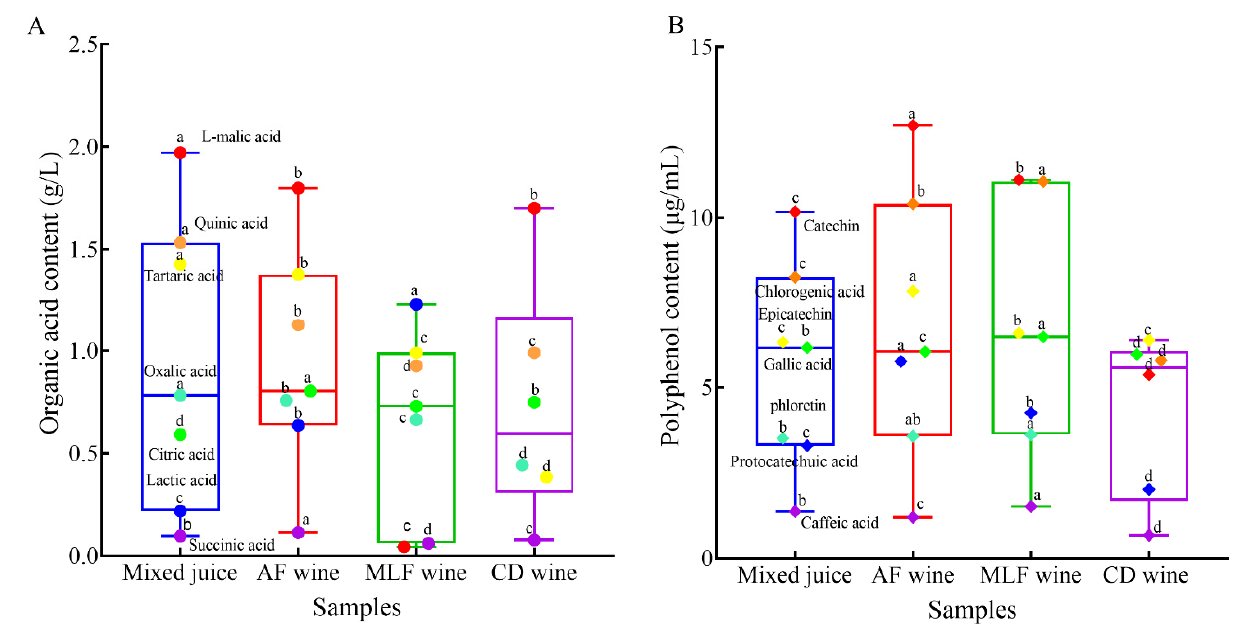
Figure 3. Deacidification modulates organic acid and polyphenol accumulation in pear–kiwifruit wine: ( A ) organic acid; ( B ) polyphenol. Mixed juice: pear and kiwifruit juice at the blend ratio of 60:40. AF wine: pear–kiwifruit juice co-inoculated with Saccharomyces cerevisiae ES488 and Metschnikowia. pulcherrima 346. MLF wine: AF wine inoculated with Oenococcus oeni strain GF-2. CD wine: wine chemically deacidified by 1.0 g/L Na 2 CO 3 , 1.0 g/L K 2 CO 3 , and 5.0 g/L KHC 4 H 4 O 6 . Data are the mean ± SD of three independent experiments. The same symbols with different letters represent significant differences ( p < 0.05).